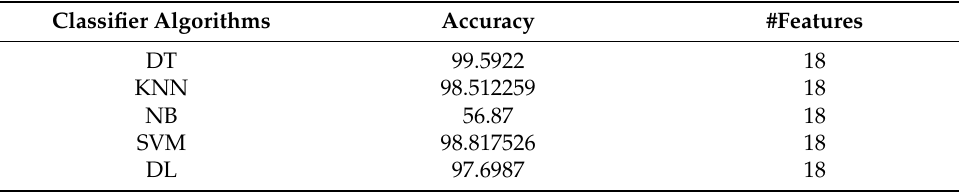
Table 6. The accuracy results of five classifier algorithms for WSN-DS dataset. Classifier